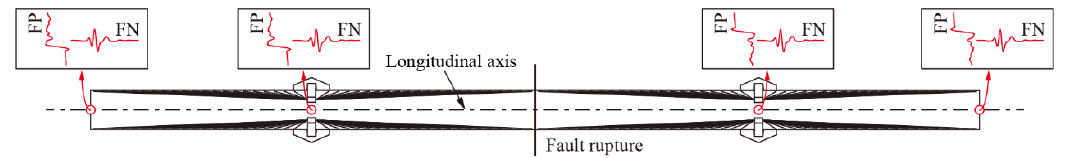
Figure 7. Input ground motions for cable-stayed bridges crossing faults.